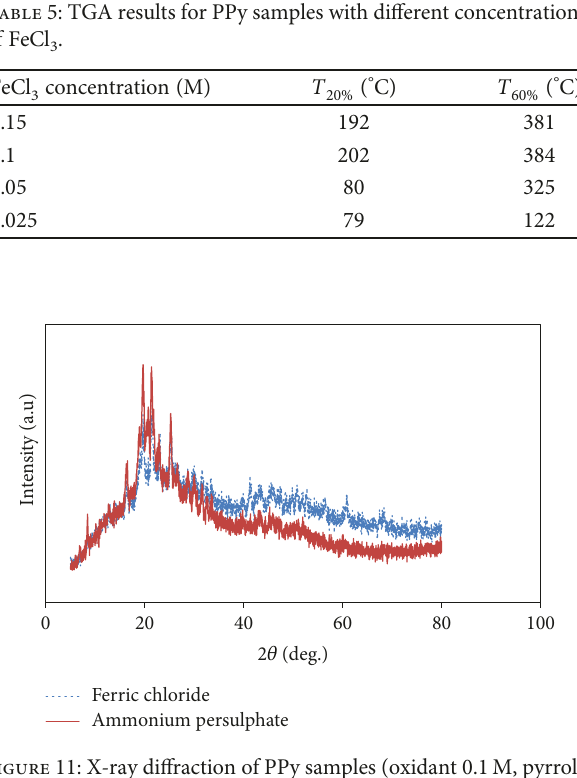
Table 3: DSC results for di ff erent FeCl concentration (M) FeCl 3